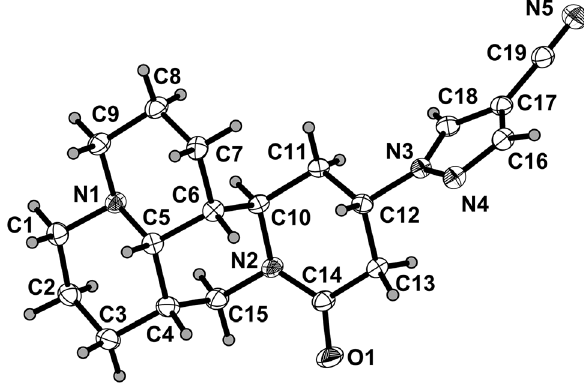
Table  : Data collection and